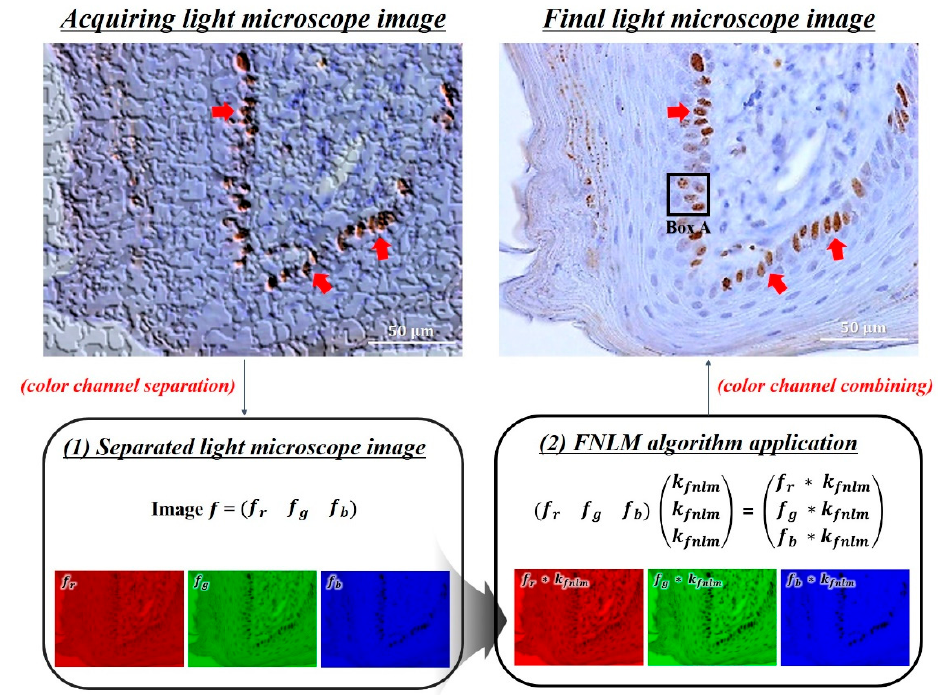
Figure 1. Simplified flowchart of applying the fast non-local means (FNLM) algorithm (at 400 × magnification) to light microscopy (LM) images (scale bar = 50 μ m ) .